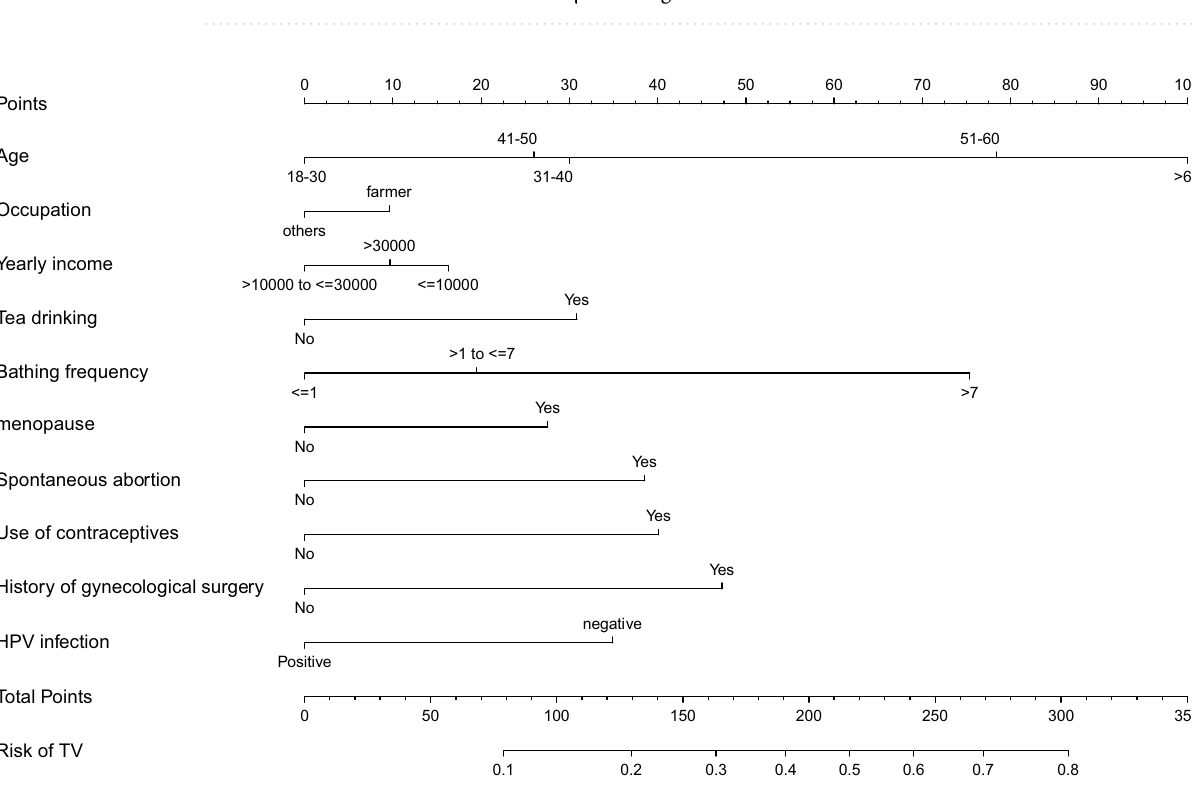
Table 2. Predictors of female TV. where β is the regression coefficient. CI confidence interval.